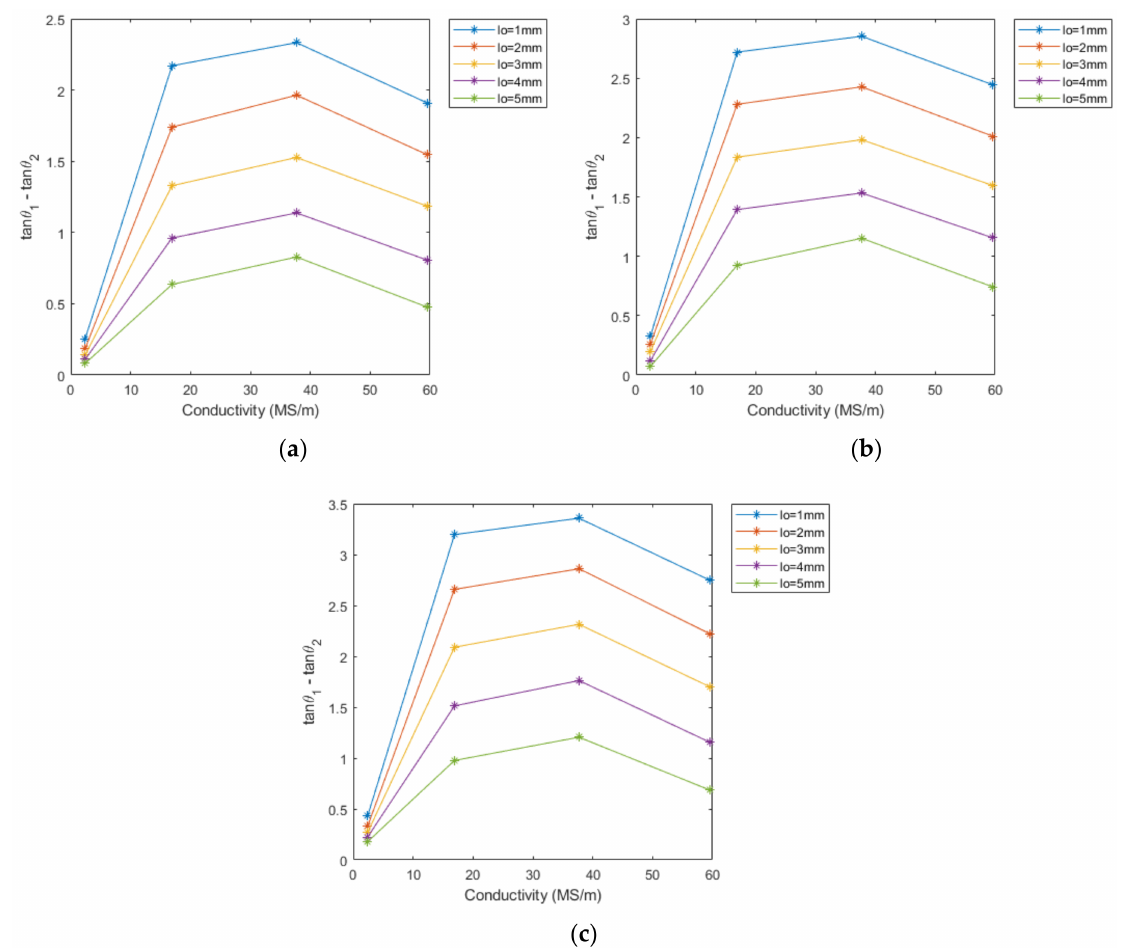
Figure 6. The feature with conductivity as a variable at different lift-offs and excitation frequencies: ( a ) 40 kHz; ( b ) 60 kHz; ( c ) 80